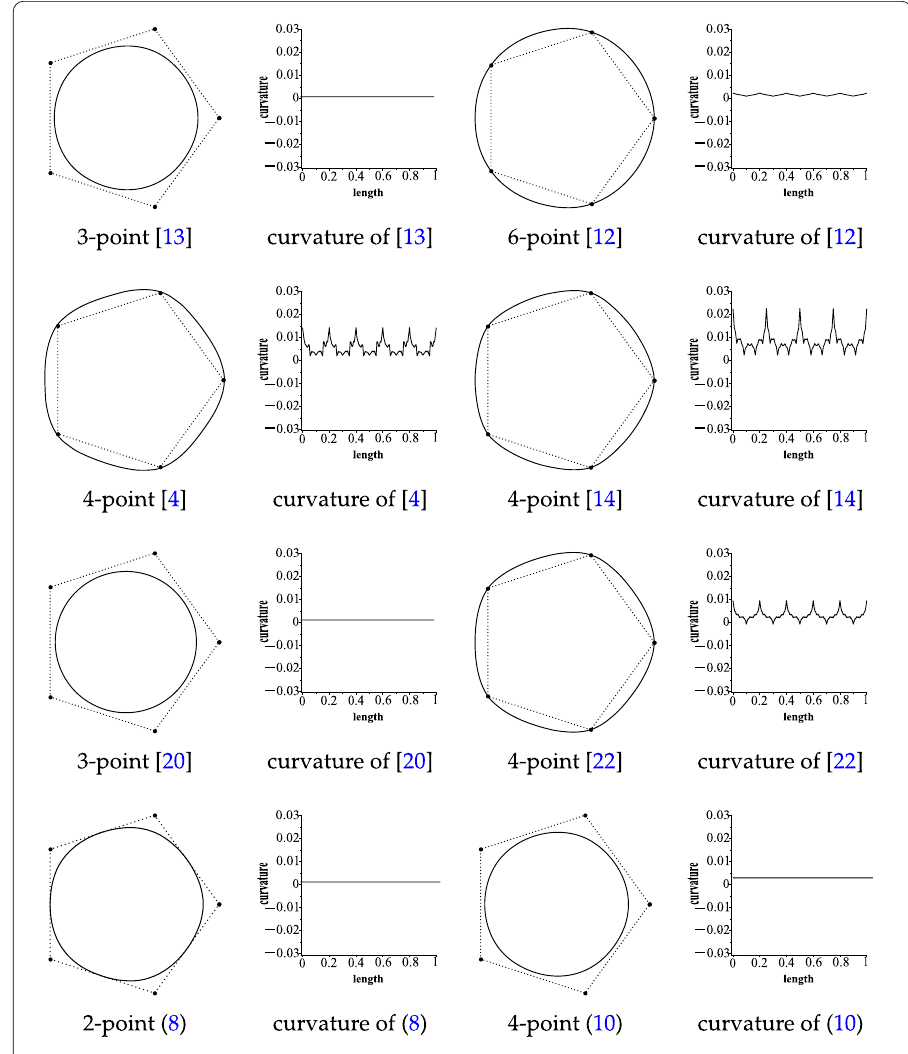
Figure 3 Comparison of the existing [4, 12–14, 22, 23] and proposed schemes (8) and (10) when five initial control points are sampled from a circle